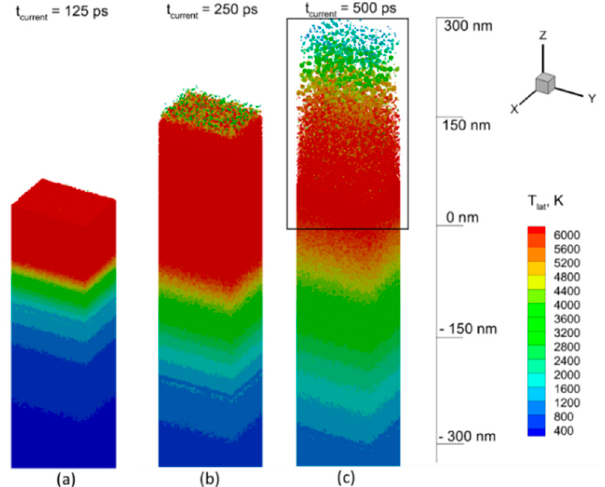
Figure 9. The lattice temperature field is shown for simulation times of 125 ps ( a ), 250 ps ( b ), and 500 ps ( c ). The water media is blanked here for visualization of metallic part of the computational cell. The rectangular region in ( c ) is zoomed for a more detailed observation in Figure 10.